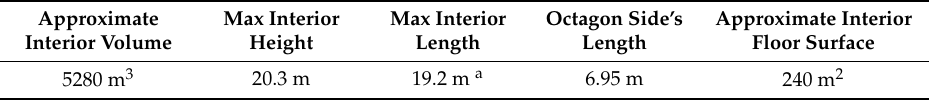
Table 1. Geometrical data of the York Minster’s Chapter House.